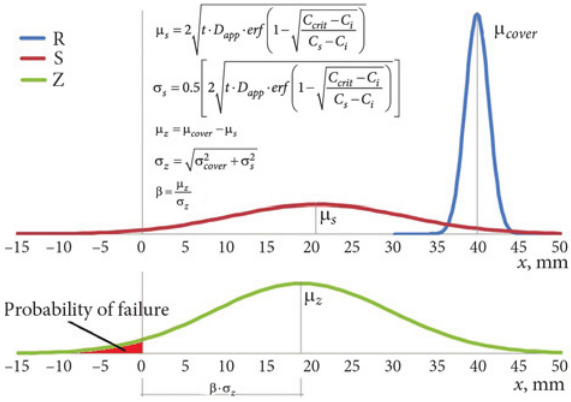
fig. 21. Reliability concept for performed